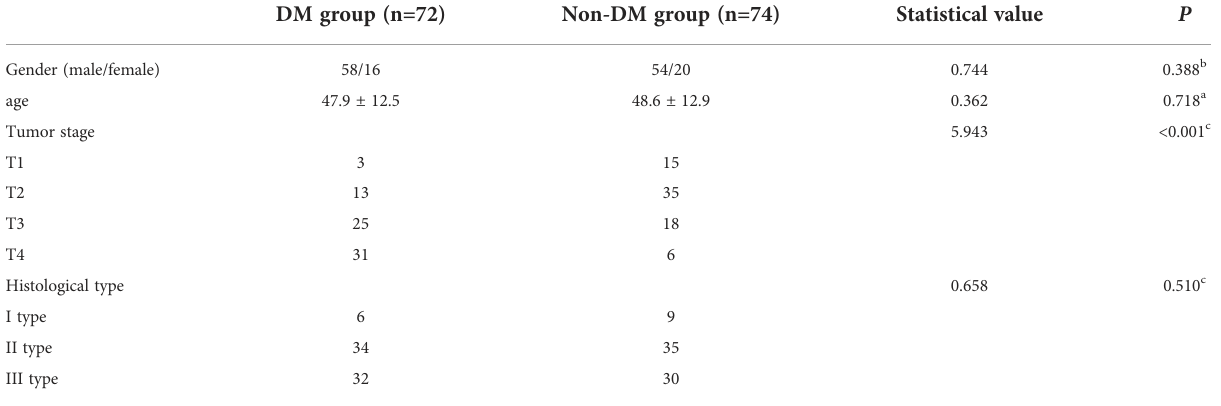
TABLE 1 Comparison of general characteristics of patients with